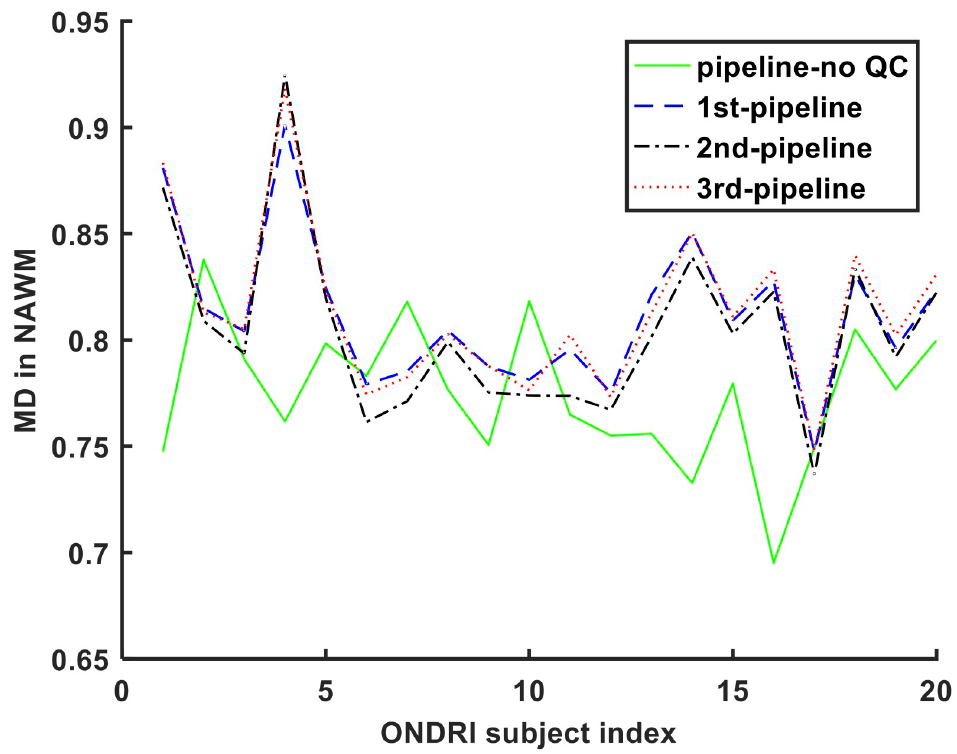
Fig 10. MD measurements in NAWM from 20 ONDRI VCI